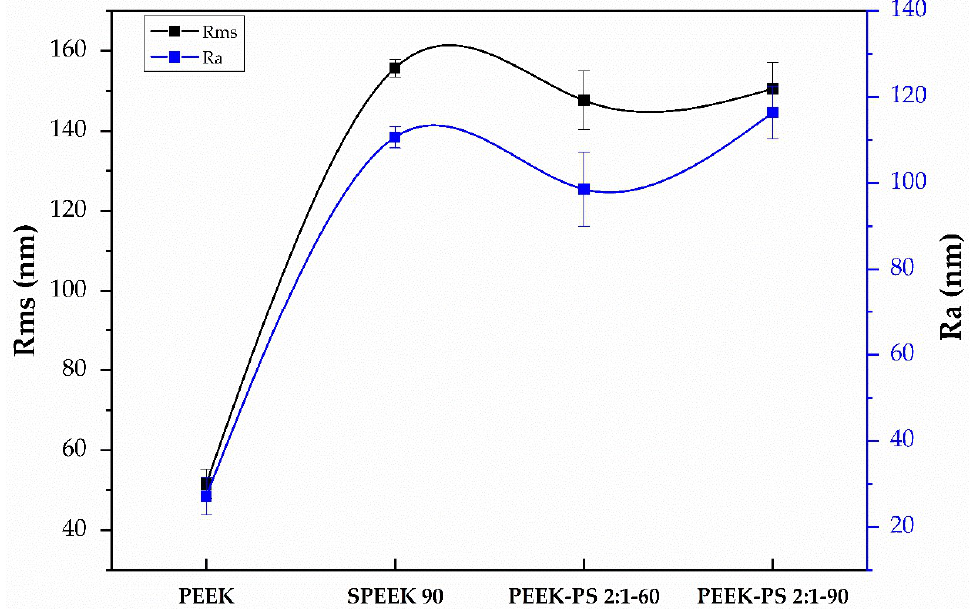
Figure 10. Surface roughness of untreated PEEK, SPEEK 90, and piranha-solution-treated PEEK-PS 2:1-60 and PEEK-PS 2:1-90 obtained from SEM micrographs using Gwyddion software. Results are presented as means ± SD ( n = 3). p -value < 0.05, p = value > 0.05.